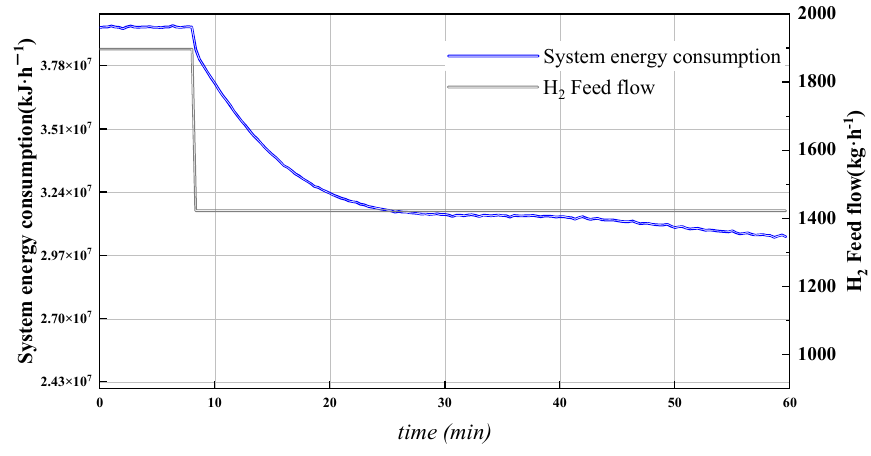
Figure 12. Process ① energy consumption curve after PID parameters were adjusted.